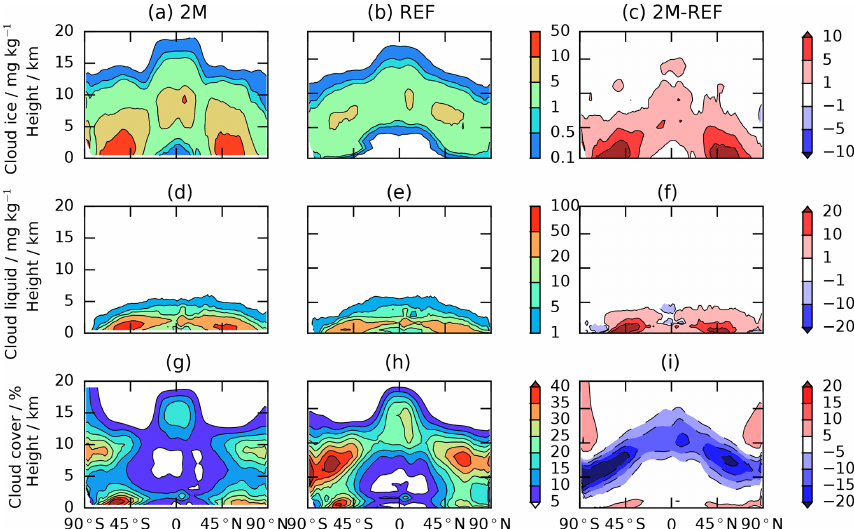
Figure 2. The 10-year zonal mean cloud ice water content (a, b, c) , cloud liquid water content (d, e, f) and cloud cover (g, h, i) for the new model (2M configuration; a, d, g ), the reference model (REF; b, e, h ) and differences between the two schemes (c, f, i) .